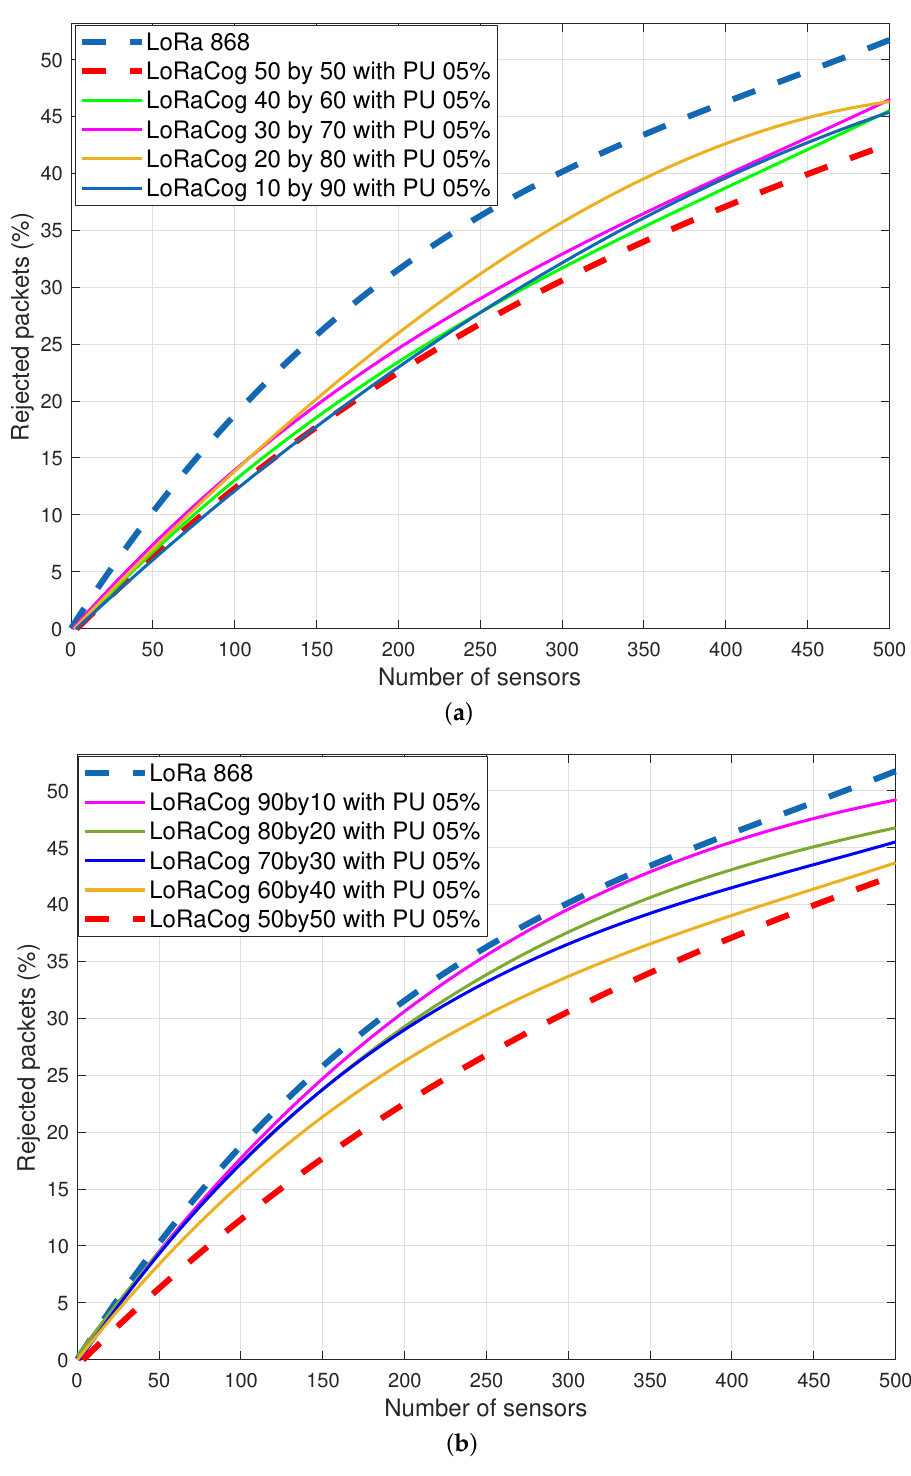
Figure 12. Evolution of the rejected packets for LoRaWAN and LoRaCog for a probability of re- appearance of 5%. ( a ) More than 50% of the EDs are operating on the cognitive channel. ( b ) Less than 50% of the EDs are operating on the cognitive